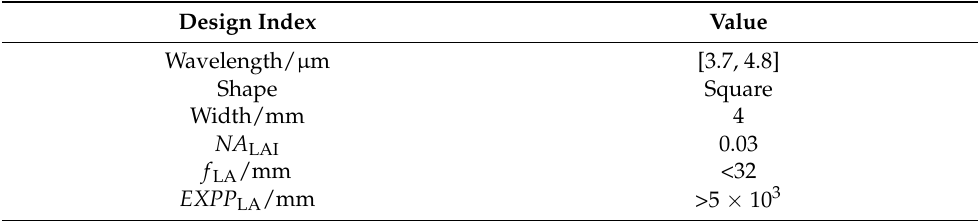
Table 3. Lens unit design index.